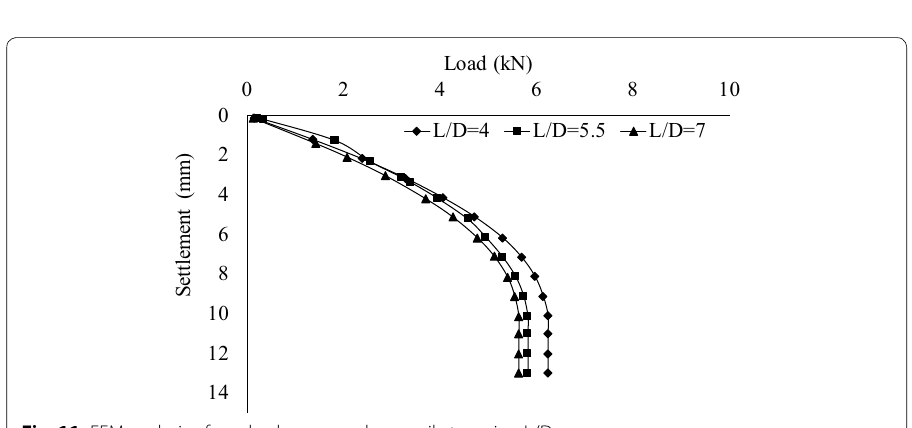
Fig. 11 FEM analysis of sand columns on clayey soil at varying